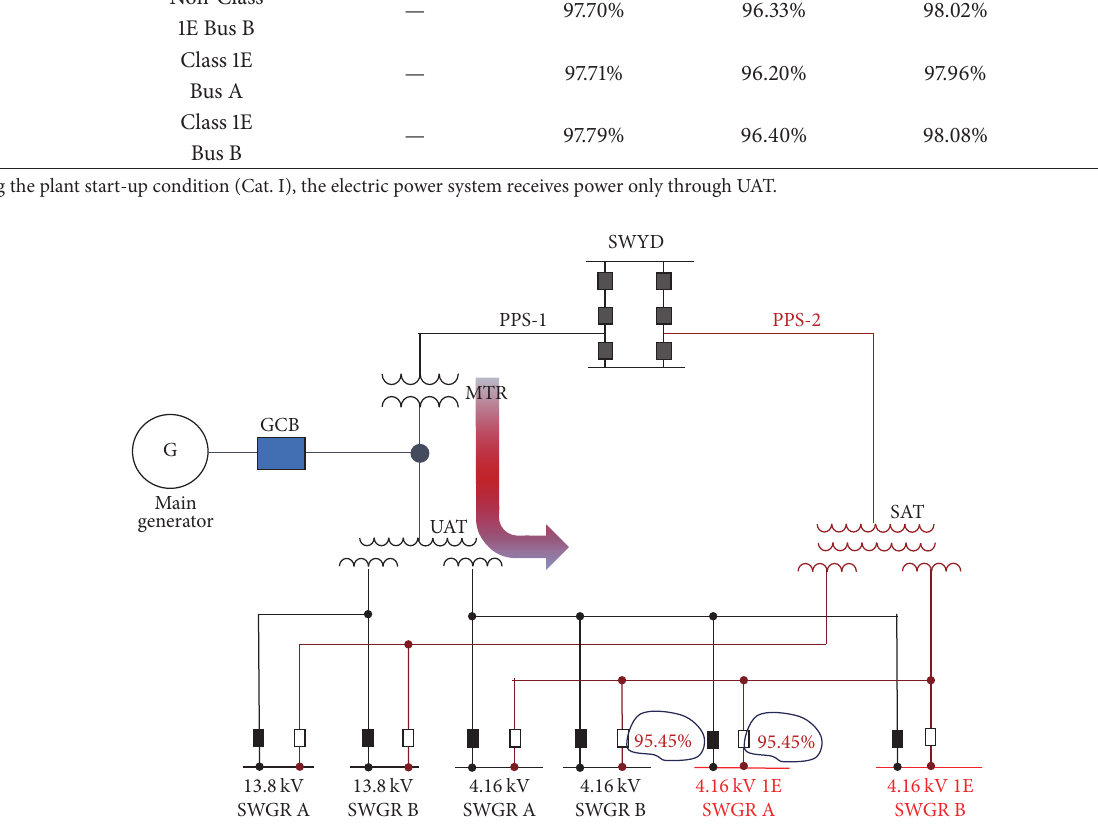
Figure 2: Voltage variation during the start-up